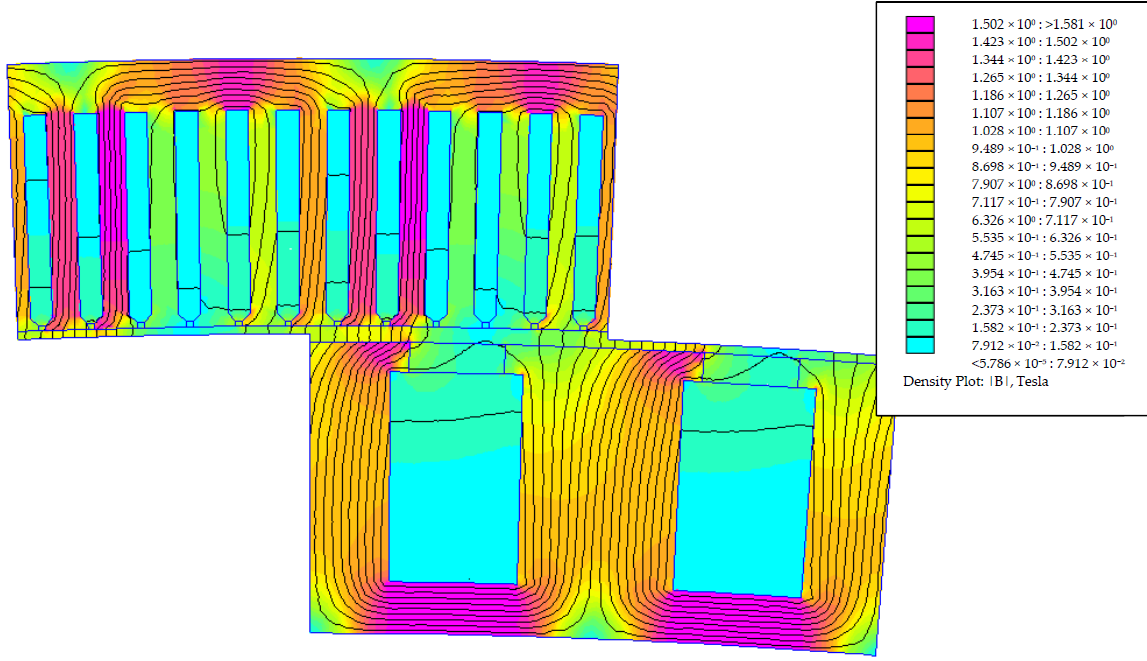
Figure 13. Distribution of the flux density in the machine for the nominal power.